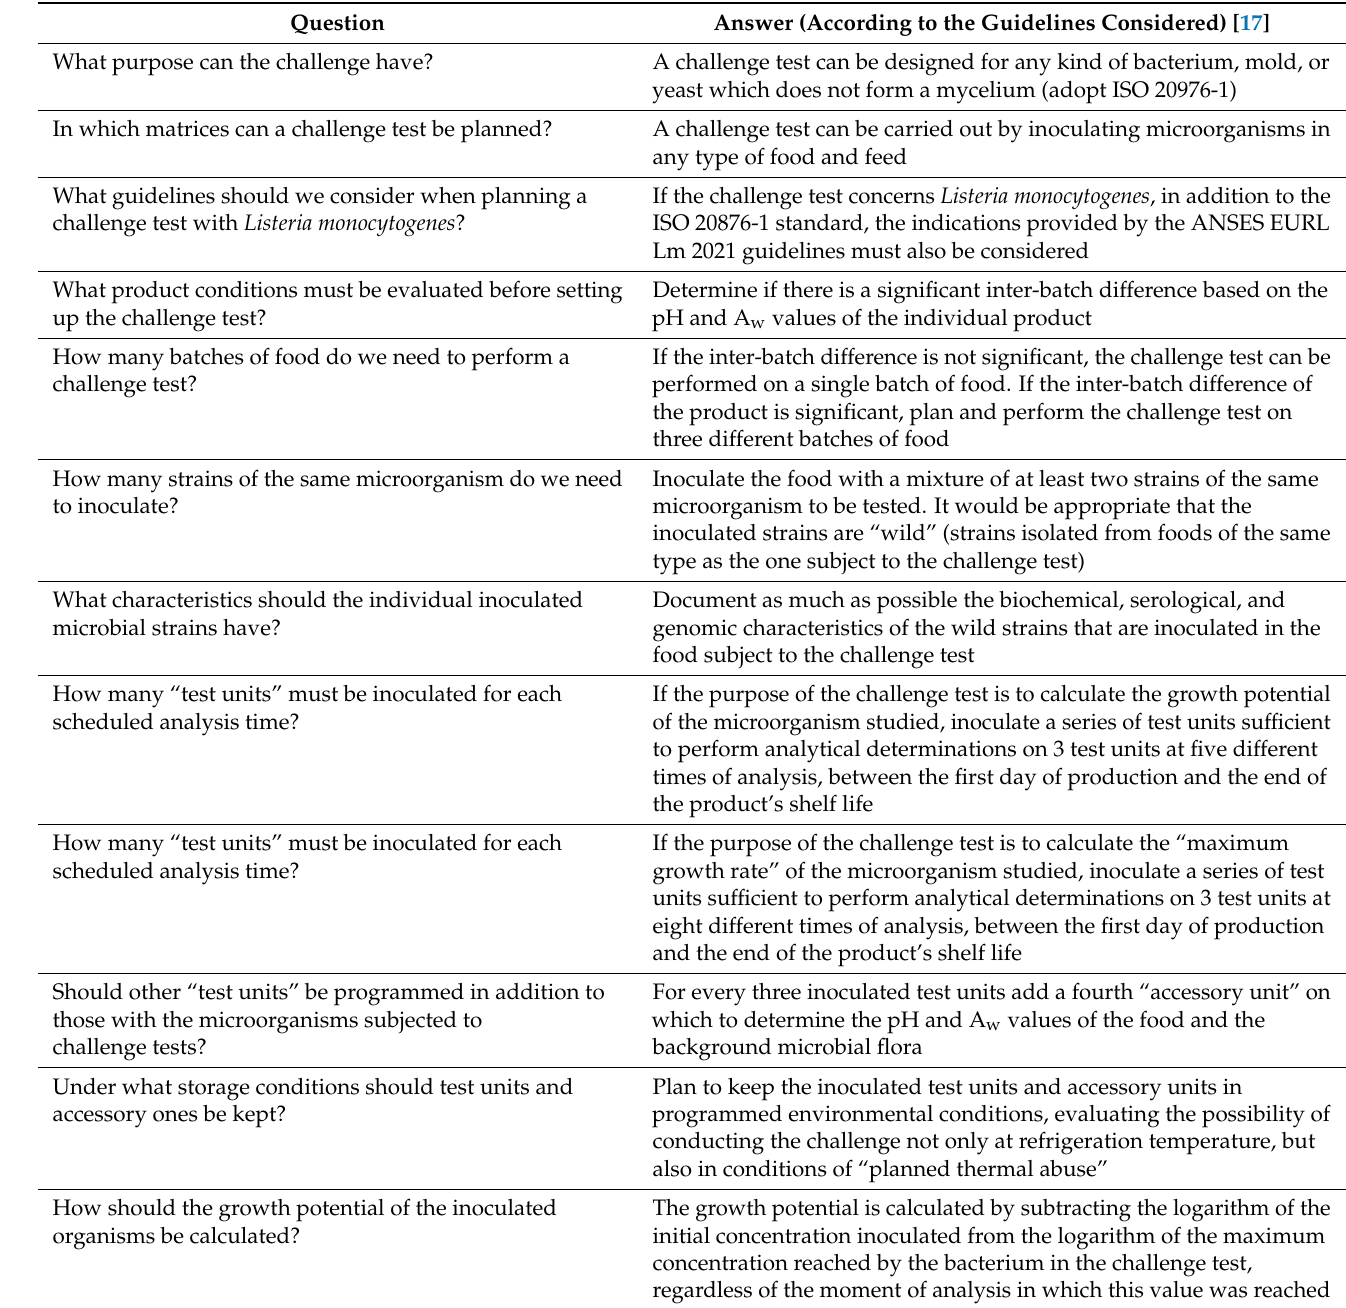
Table 3. Key points that the FBO must keep in mind to design and implement an effective